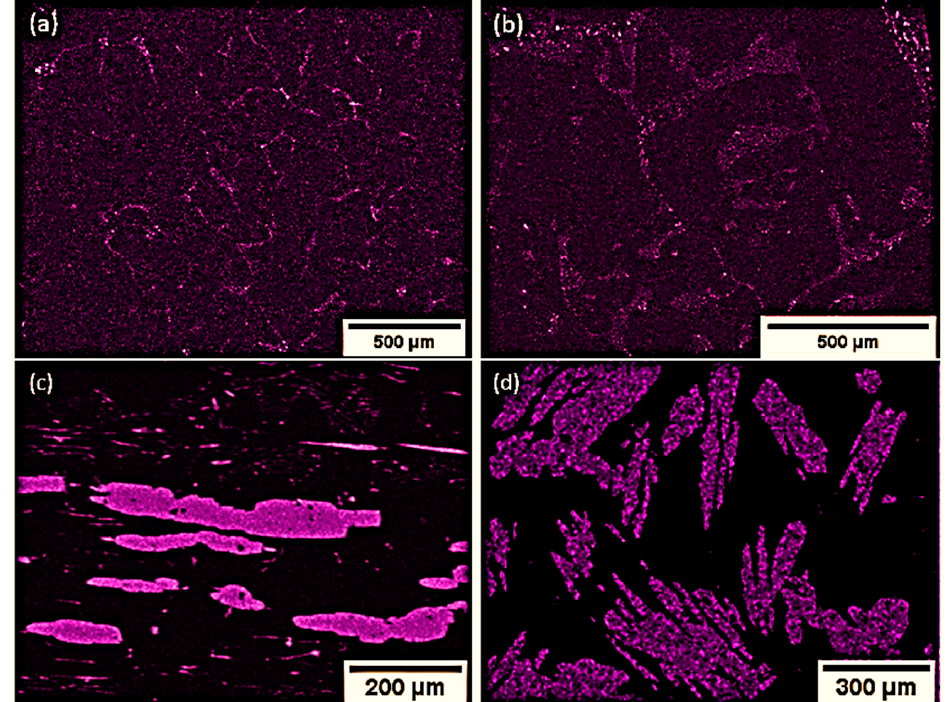
Figure 3. Representative energy dispersive spectroscopy (EDS) maps showing the distribution of Mn within samples of various compositions: ( a ) 1 at.%; ( b ) 2 at.%; ( c ) 20 at.% magnetically annealed; ( d ) 20 at.% unannealed. Image contrast has been enhanced digitally for clarity. Bi maps (not shown) reveal Bi is present everywhere Mn is observed, indicating a complete reaction of all available Mn and confirming that the dark areas in backscatter electron (BSE) images in Figure 2 are MnBi. Samples with low Mn content indicate MnBi is mainly clustered at boundaries between Bi grains, while nearly percolated MnBi networks form in samples with higher Mn content, which are randomly oriented in the unannealed samples.